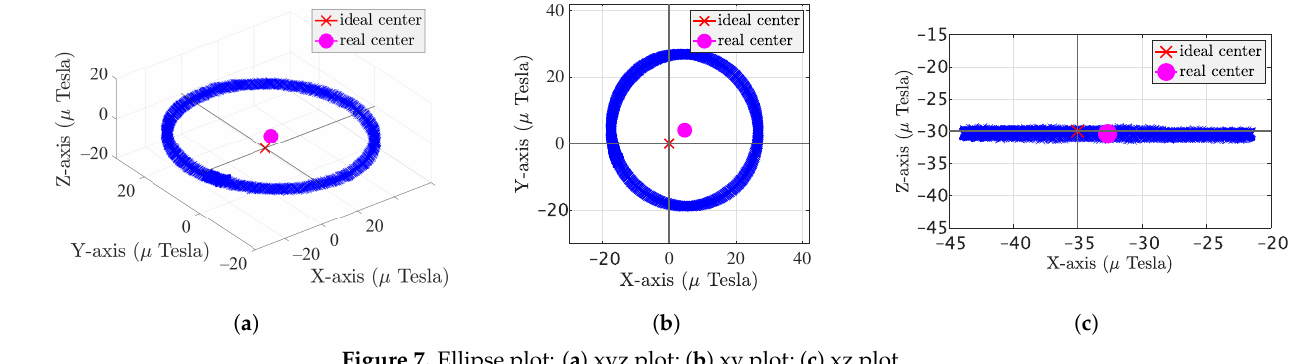
Figure 7. Ellipse plot: ( a ) xyz plot; ( b ) xy plot; ( c ) xz